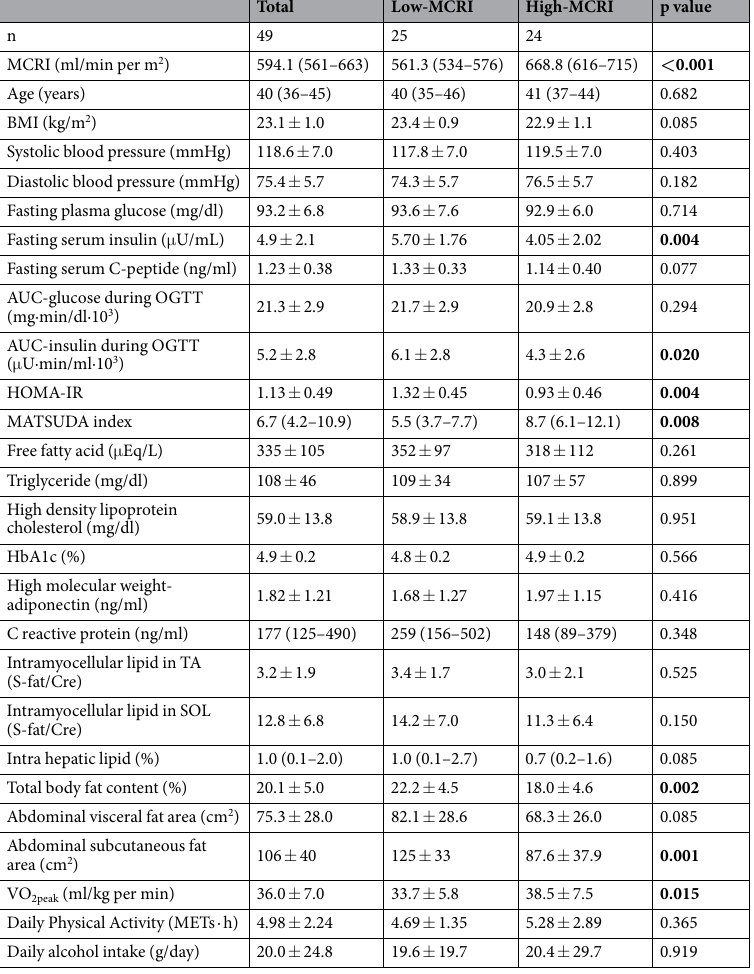
Table 1. Clinical characteristics of the Low MCRI group and the High MCRI group. Data are mean ± SD or median (interquartile range). MCRI; metabolic clearance rate for serum insulin, HOMA-IR; homeostasis model assessment of insulin resistance, TA; tibialis anterior muscle, S-fat; methylene signal intensity, VO 2peak ; peak oxygen consumption, AUC; area under the curve, OGTT; oral glucose tolerance